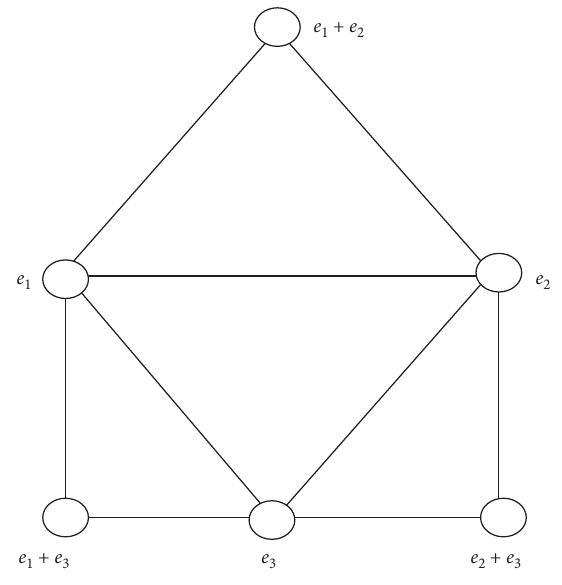
Figure 1: Γ ( V ) for n � 3 and q �